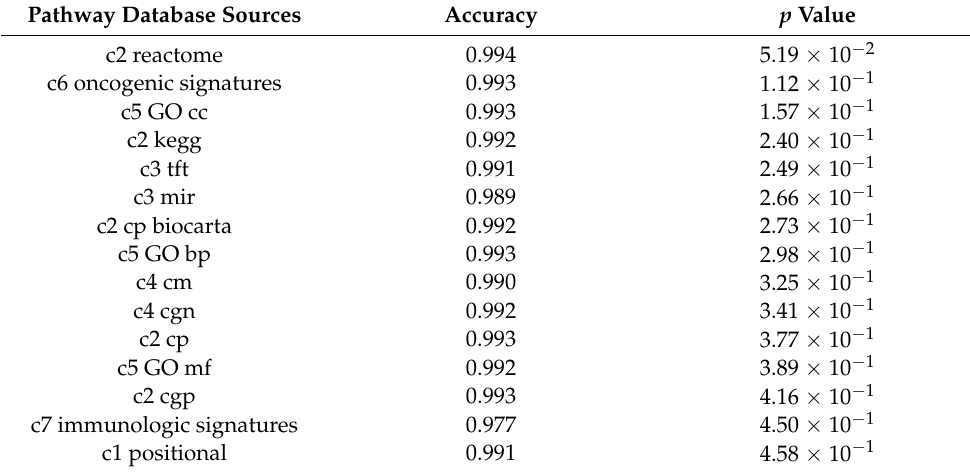
Table 1. One sample z -test of PathDeep performance for molecular signature